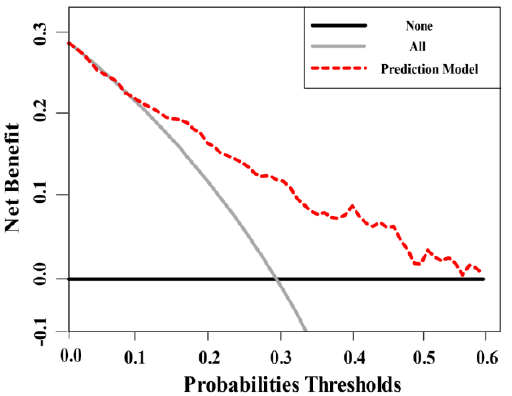
Figure 6. Decision analysis demonstrated a high net benefit of the model across a wide range of threshold